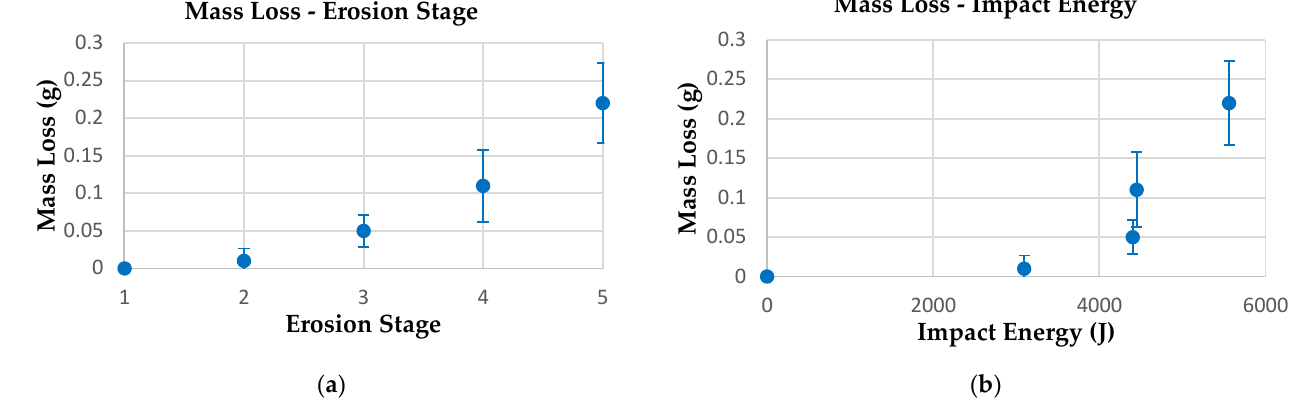
Figure 6. Plots of mass loss vs.: ( a ) Erosion Stage; ( b ) Impact Energy. Looking at all the data presented, it is clear that the erosion is concentrated on a particular zone of the sample surface. This is due to the nature of the RET rig used. The ETC rig uses a repeated bombardment of rain droplets on a focused area of the sample and not across the whole sample surface, whereas other RET rigs may use different rain droplet